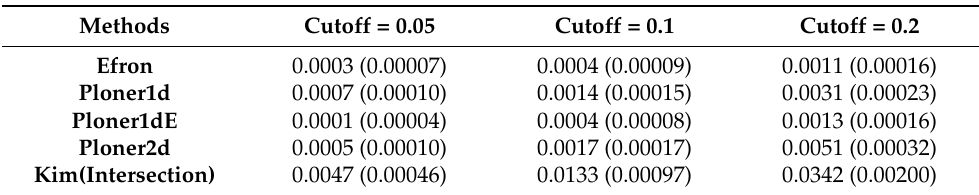
Figure 4. Basic scenario and two-sided. Estimated fdr2d for union null ( a ) and intersection null ( b ). For each method, mean and standard error of the estimated FDRs over 100 repetitions are summarized in Table 1. As seen in Table 1, all procedures control local FDR strictly. Table 1. Basic scenario (two-sided alternative): means and standard errors of estimated FDRs over 100 repetitions.